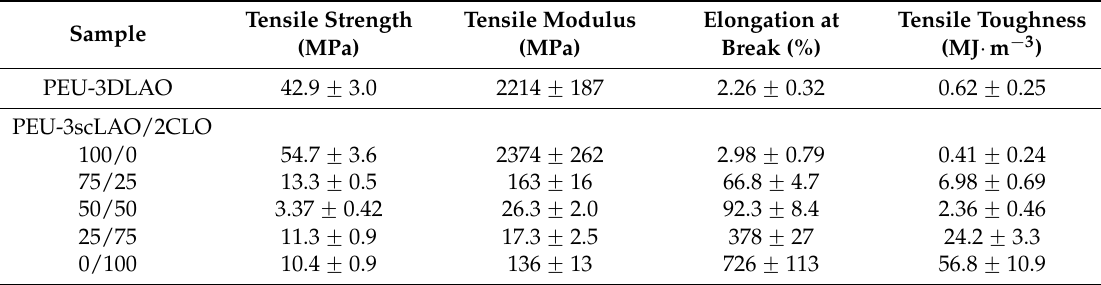
Table 3. Tensile properties of PEU-3DLAO and PEU-3scLAO/2CLOs (100/0, 75/25, 50/50, 25/75 and 0/100).